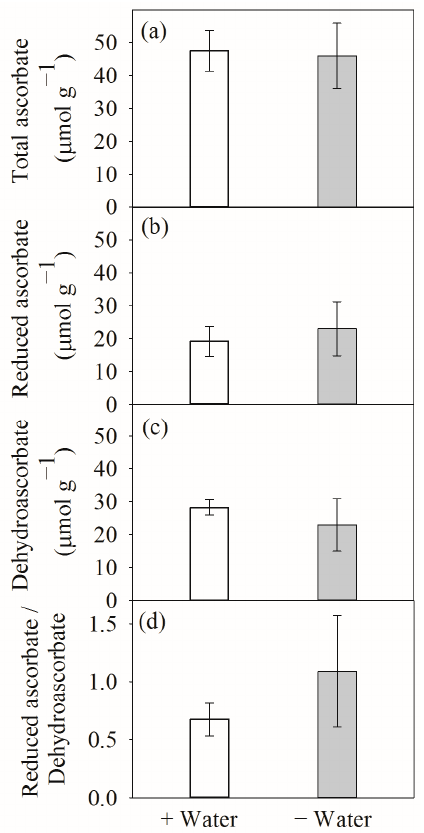
Figure 5. Contents of total ( a ), reduced ascorbate ( b ), dehydroascorbate ( c ), and ratio between reduced and dehydroascorbate ( d ) in leaves of Alnus glutinosa grown under sufficient (+ water, blank bars) and limited water conditions ( − water, grey bars). Data shown represent mean ± standard deviation ( n = 5) on a dry weight basis. No significant differences ( p < 0.05) between trees with sufficient and limited water supply were found in all parameters.